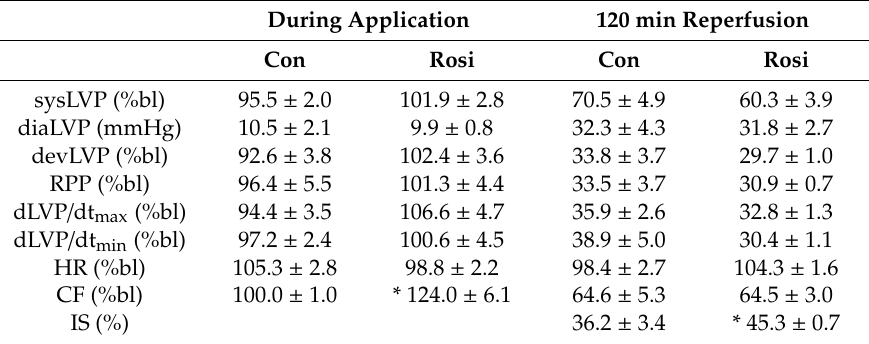
Table 1. Myocardial Function and Infarct Size. This table shows myocardial function during the application of the thiazolidinedione rosiglitazone (Rosi, 50 µ M, n = 5), and myocardial function and infarct size at 120 min reperfusion following 30 min global no-flow ischemia compared to control (Con, n = 7) rat isolated